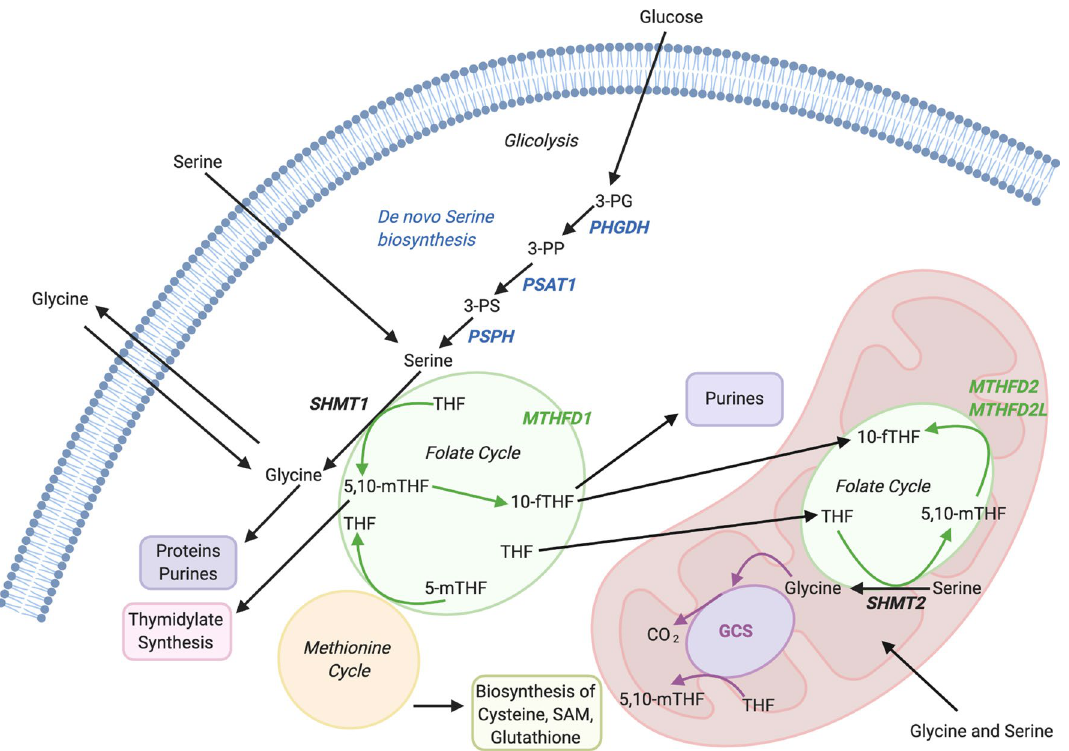
Fig. 1 Schematic representation of the one-carbon metabolism. The schematic image describes biochemical pathway involved in serine and glycine biosynthesis and in one carbon metabolism, a group of reactions necessary to production of proteins, purines, thymidylate, methionine, cysteine, S -adenosyl-methionine (SAM) and glutathione. Regarding one-carbon units, the current image shows a strong meta- bolic connection between cytoplasmatic, and mitochondrial enzymes involved in THF production, serine de novo biosynthesis and serine and glycine catabolism. Cytoplasmatic enzymes: PHGDH phosphoglycerate dehydrogenase, PSAT1 phosphoserine aminotransferase 1, PSPH phosphoserine phosphatase, SHMT1 serine hydroxymethyltransferase 1; mitochondrial enzymes: SHMT2 serine hydroxymethyltransferase 2, MTHFD1 methylenetetrahydrofolate dehydrogenase1, MTHFD2 methylenetetrahydrofolate dehydrogenase2, MTHFD2L methylenetetrahy- drofolate dehydrogenase NADP+ dependent 2 like, GCS glycine cleavage system. Biochemical compounds: 3-PG 3-phospoglycerate, 3-PP 3-phosphopyruvate, 3-PS 3-phosposerine, THF tetrahydrofolate, 5,10-me-THF 5,10-methylenetetrahydrofolate, 5-me-THF 5-methylenetet- rahydrofolate, 10-f-THF